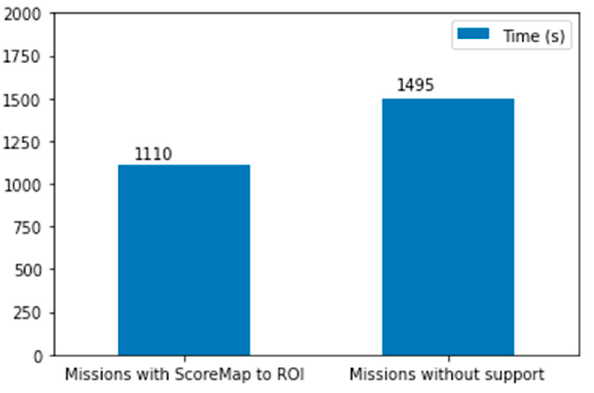
Figure 16. Average inspection time for each mission type.